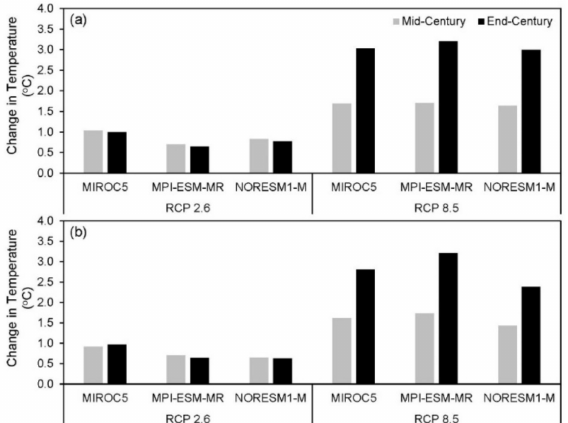
Figure 5. Changes of daily minimum ( a ) and maximum ( b ) temperatures in the Kalu River Basin under RCP 2.6 and RCP 8.5 of three RegCM4 RCMs compared with the baseline period (1991–2005) over the Kalu River